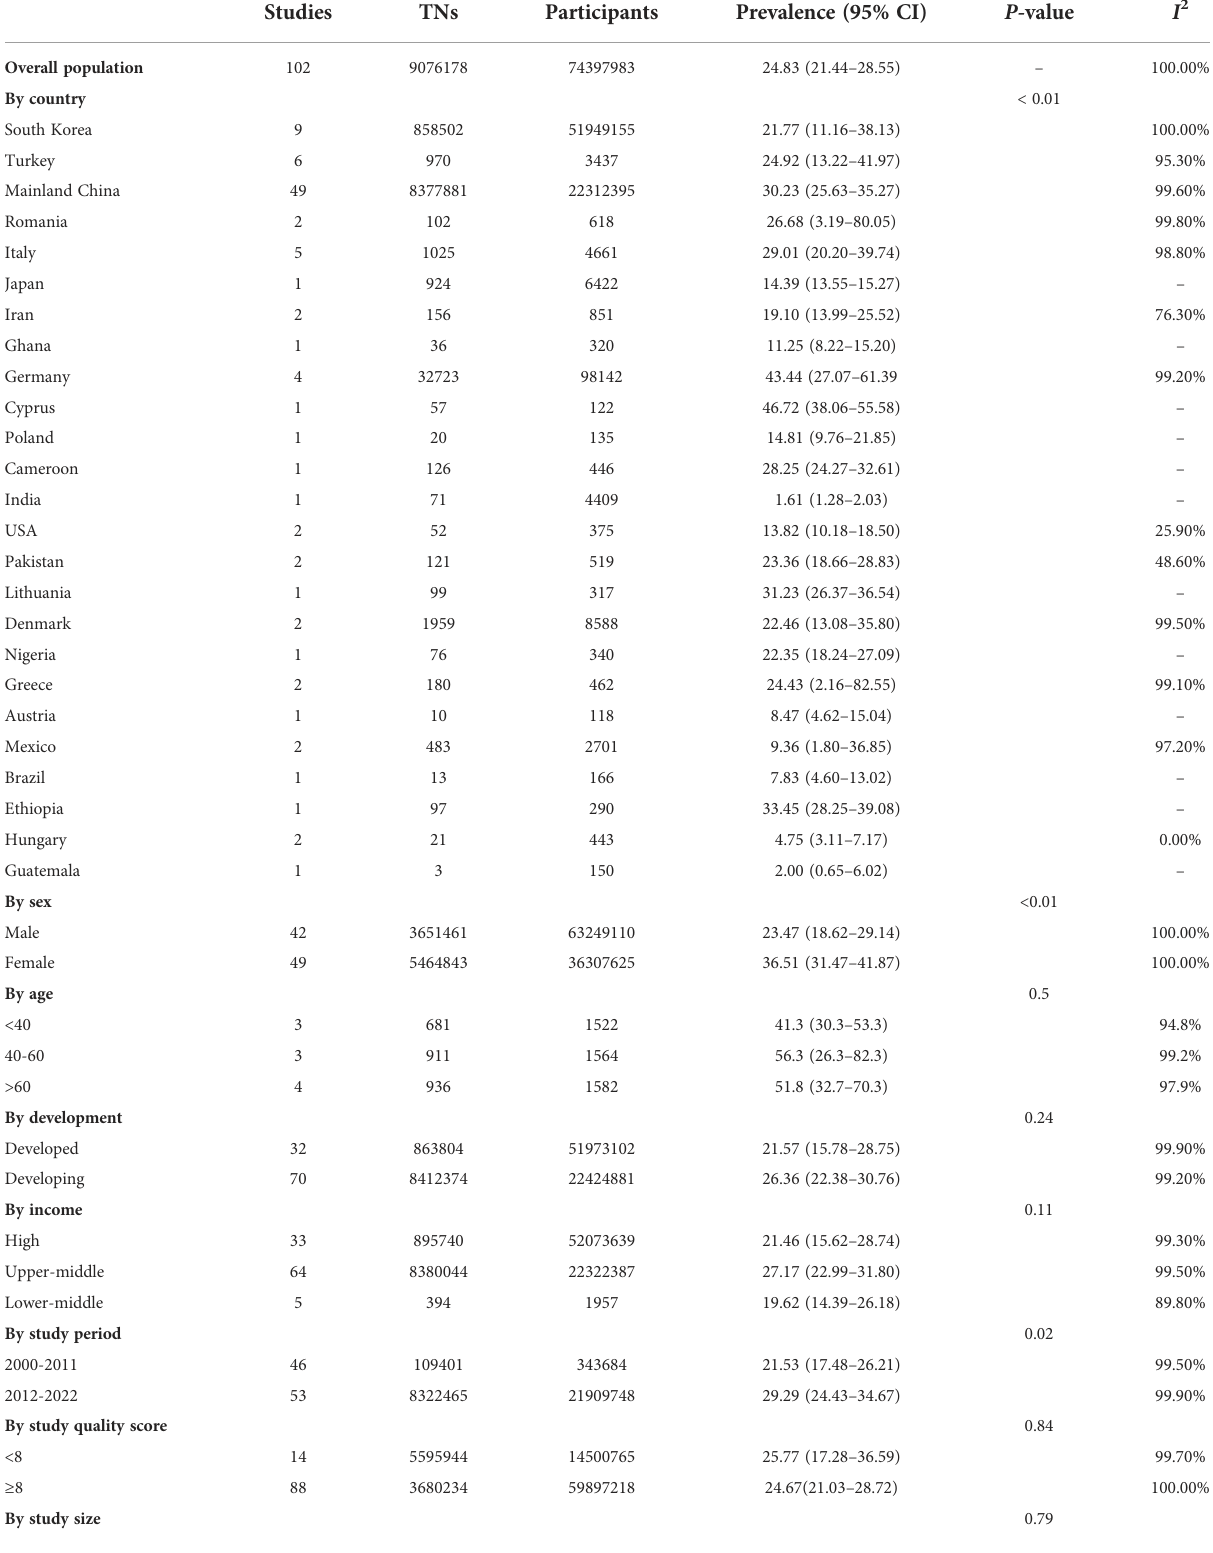
TABLE 1 Subgroup analysis for thyroid nodules prevalence among the general